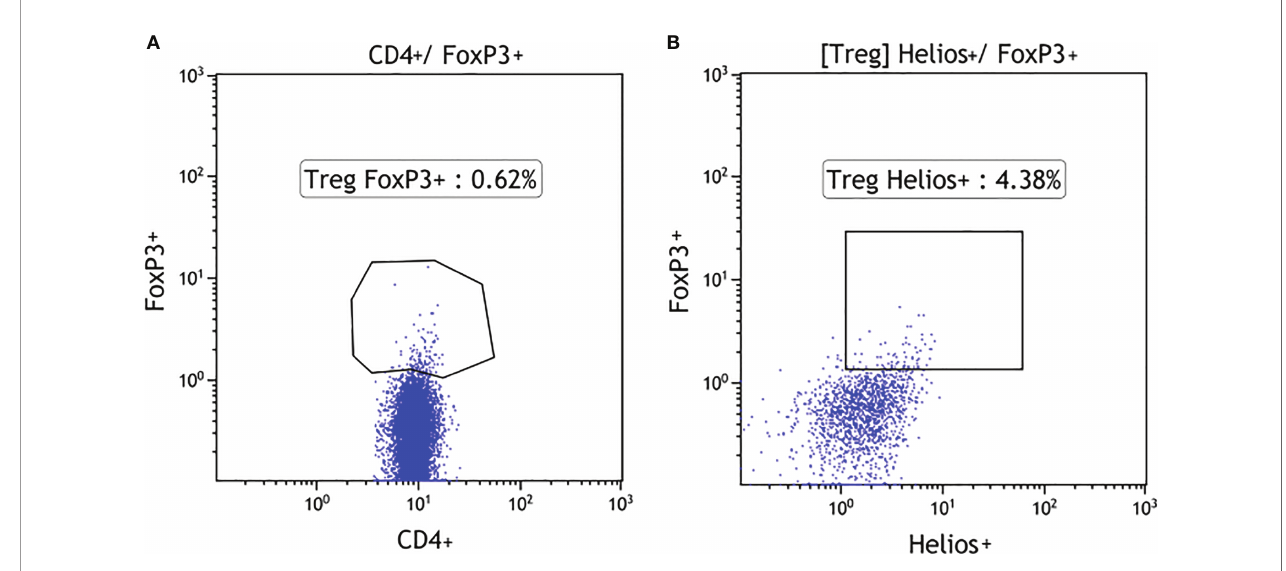
FIGURE 4 | Percentage of Treg FOXP3+ cells in 18q del patients without and with haploin suf fi ciency of TNFSF11A (A) and NEDDL4 genes (B)